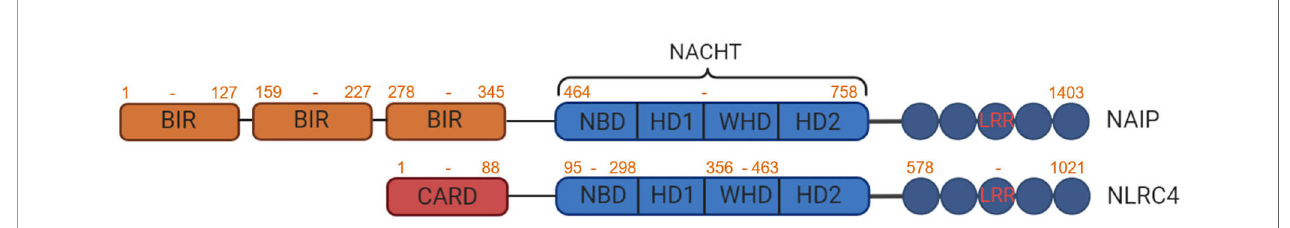
FIGURE 1 | Protein domain structure of NAIP and NLRC4. NAIPs and NLRC4 share two common domains, the NACHT domain composed of nucleotide binding domain (NBD), helical domain 1 (HD1), winged helix domain (WHD) and helical domain 2 (HD2) and a C-terminal LRR. In addition, NAIP has three Baculovirus Inhibitor-of-Apoptosis repeat (BIR) domains and NLRC4 contains an N-terminal